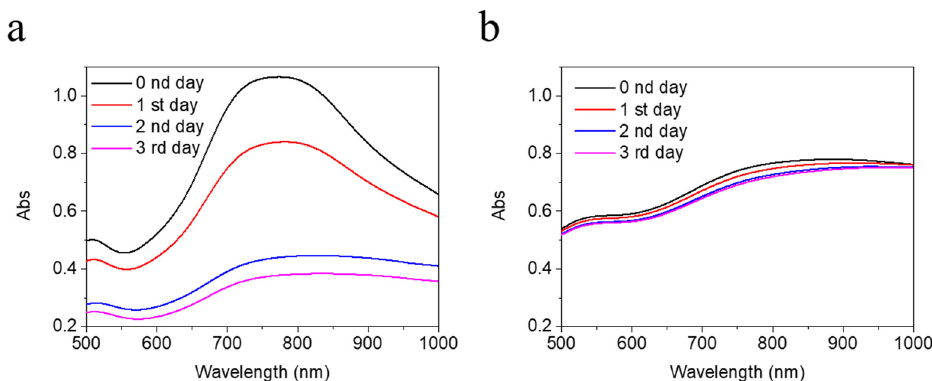
Figure 4. UV absorption of 0.5 mM ( a ) BAu and ( b ) Man@BAu NPs in 150 mM HEPES for 1 to 3 days for testing their stability. UV spectrum of Man@BAu NPs showed more stability.